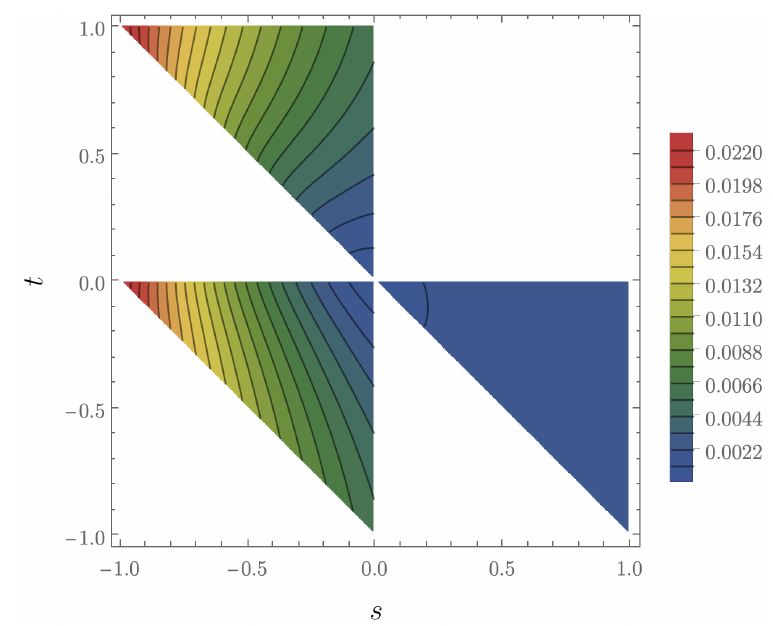
= 1 and normalized by t 8 s